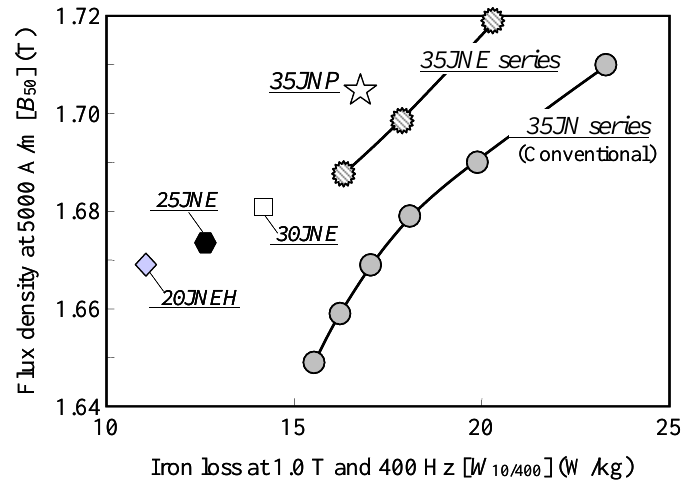
Figure 12. Map of magnetic properties by iron loss W 10/400 and material flux density B 50 .